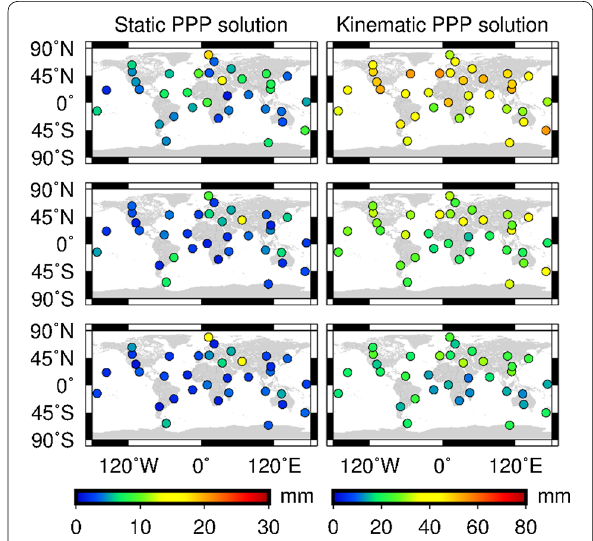
Fig. 14 Horizontal RMS of static PPP ( left ) and kinematic PPP (right) for Galileo-only ( top ), GPS-only ( middle ), and combined Galileo/GPS ( bottom